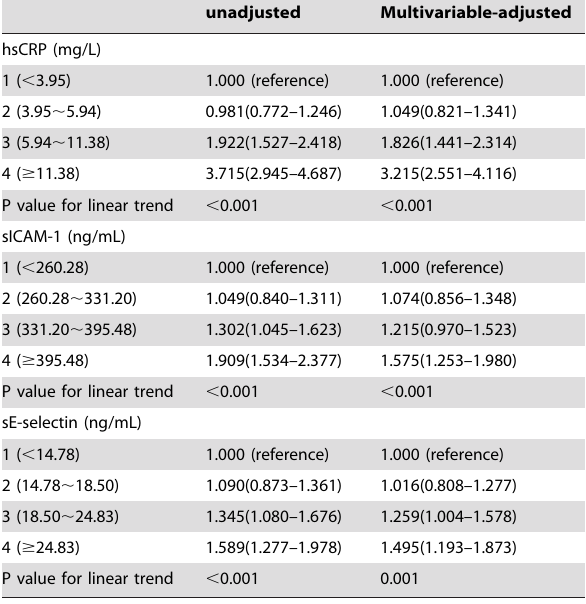
Table 2. Unadjusted and Adjusted Odds Ratios (OR) and 95% Confident Intervals (CI) of Dyslipidemia Associated with Elevated Inflammatory